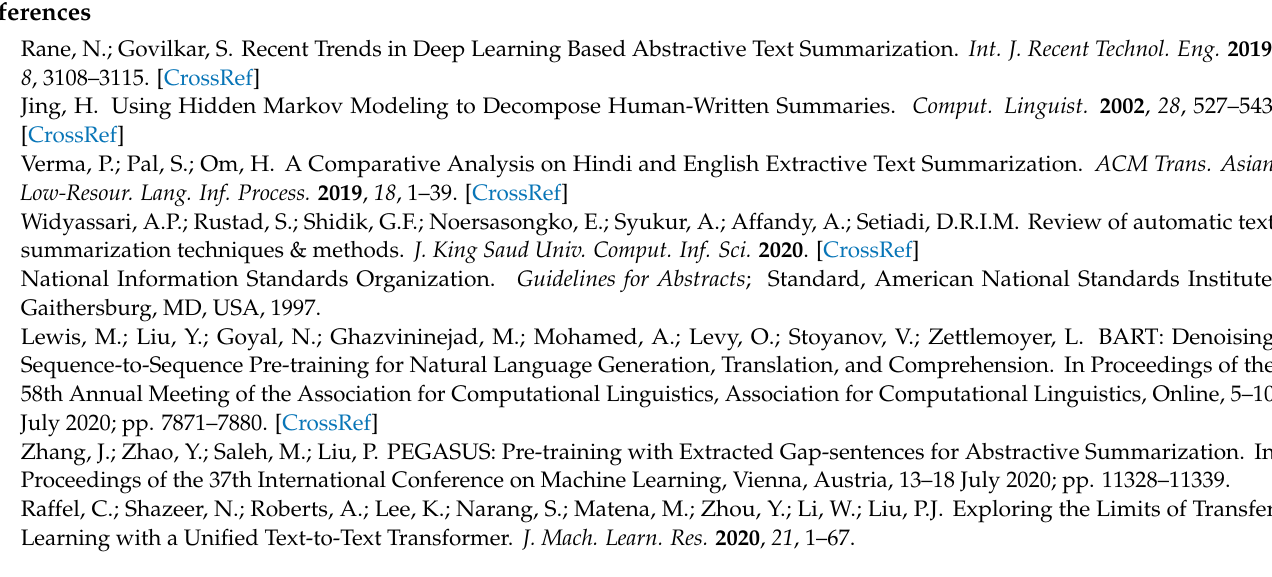
Figure A1. Text of the article, the reference summary, and the summaries generated by the